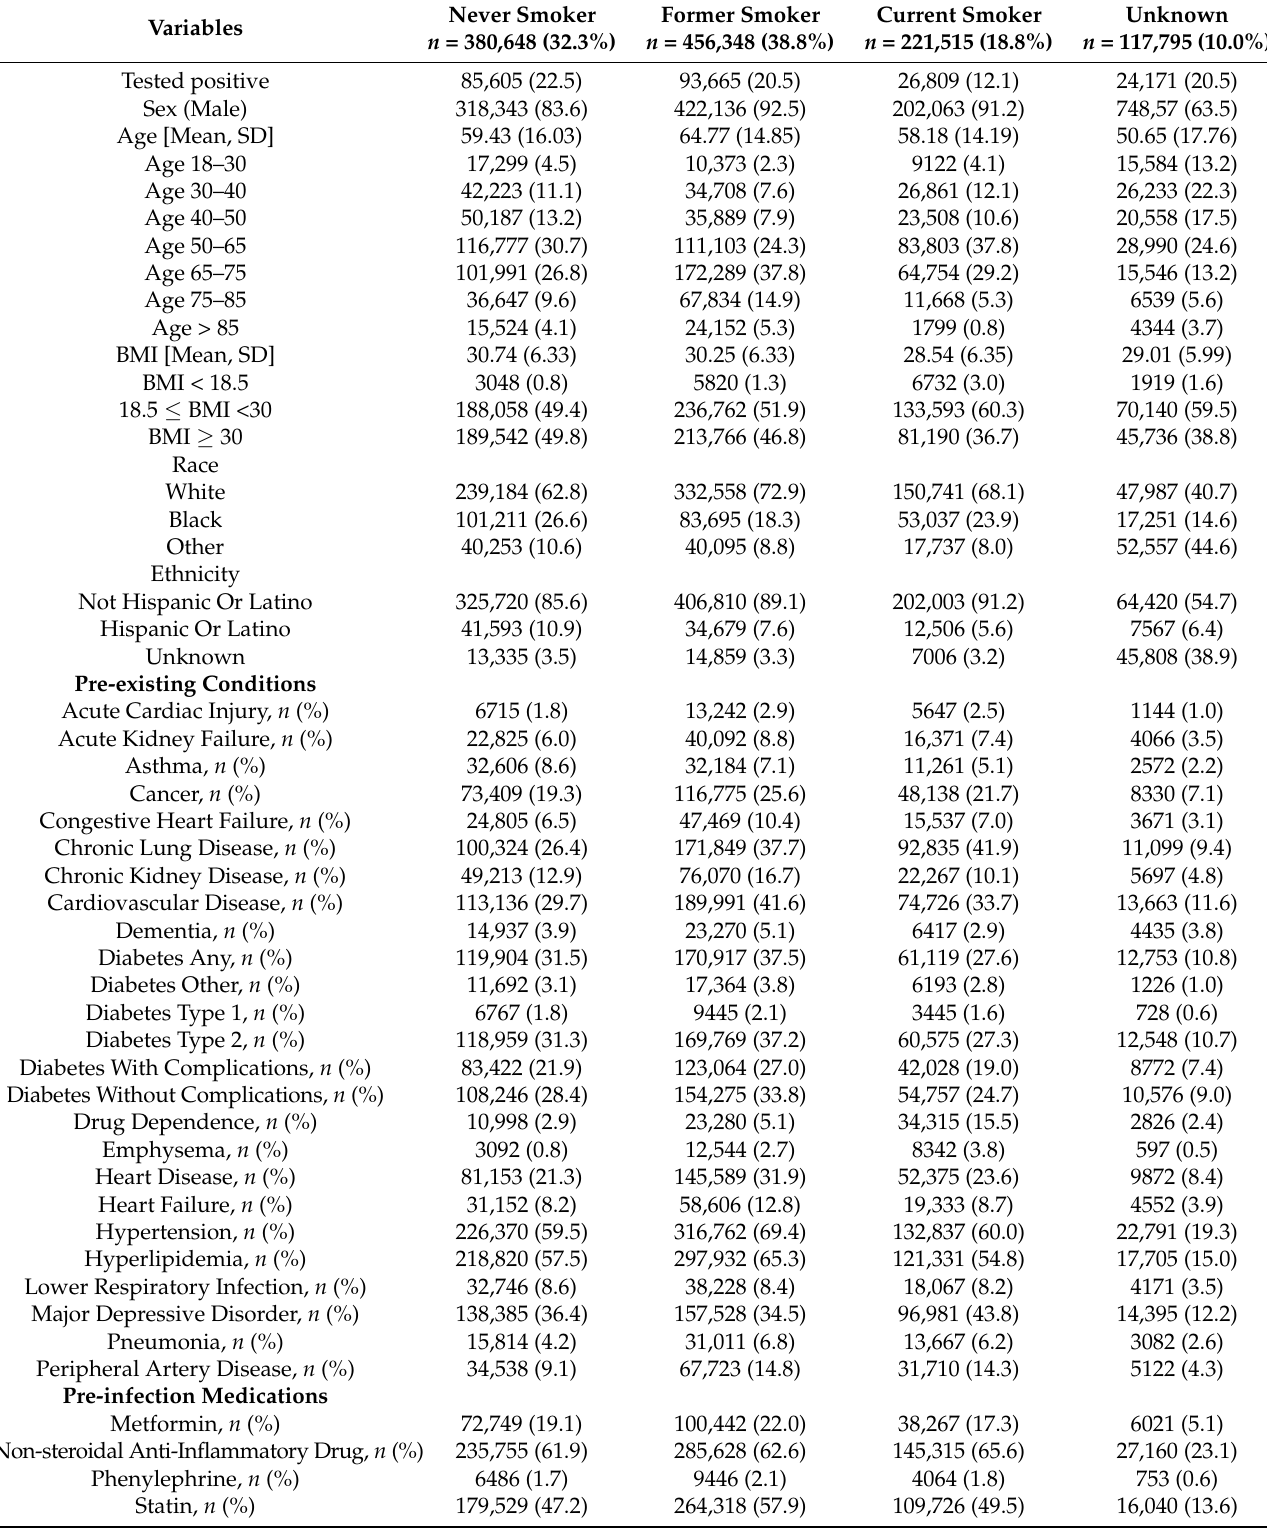
Table 1. Patients’ demographics and